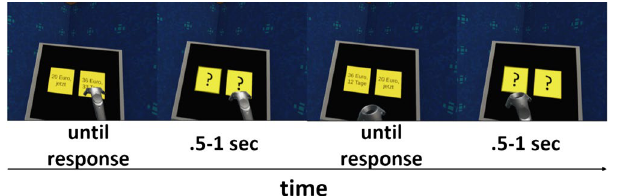
Figure 2. Presentation of the temporal discounting task in VR. Participants had to repeatedly decide between a small but immediate reward (SS) and larger but temporally delayed rewards (LL). Amounts and delays were presented in yellow squares. During the inter-trial intervals (.5–1 s) these squares contained only question marks. Participants indicated their choice by pointing the VR-controller at one of the yellow squares and pulling the